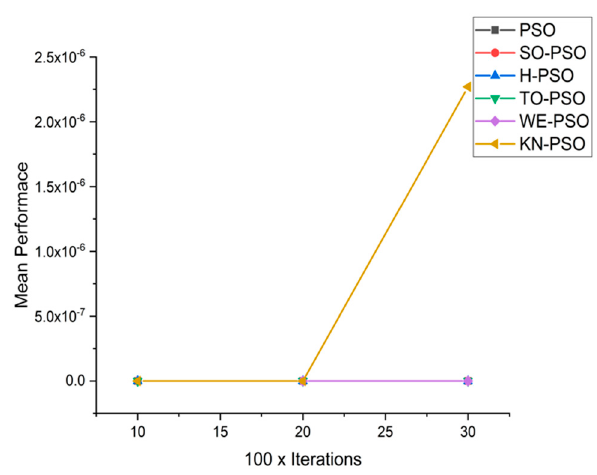
Figure 21. Convergence curve on fn15.